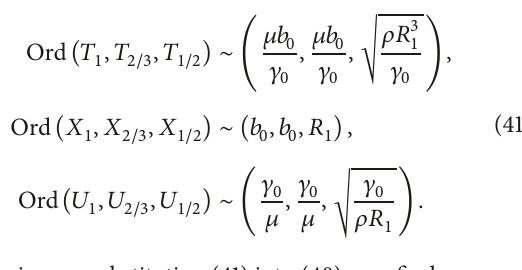
(𝑡 ) 5 = (10𝑘) 5 𝑘 𝑘=0 𝑘=0